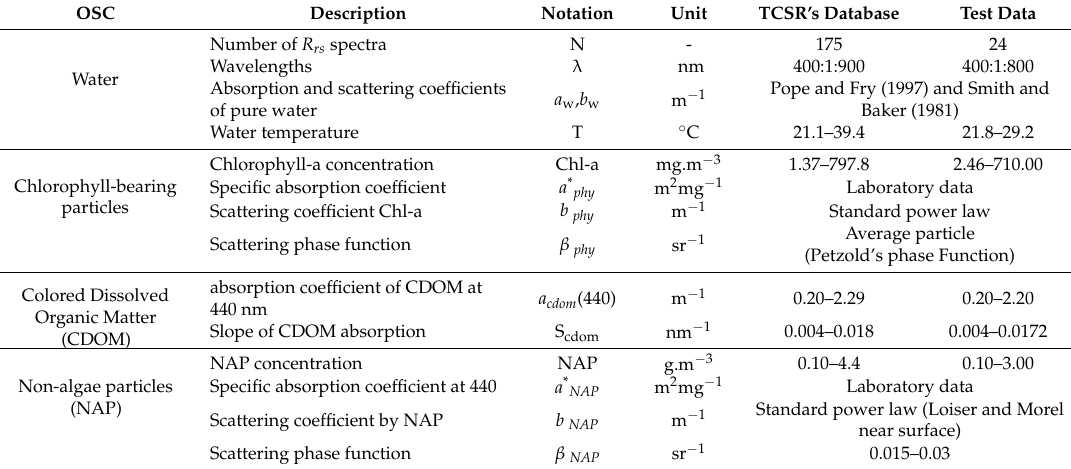
Table 3. Inputs of Hydrolight of simulations using case-2